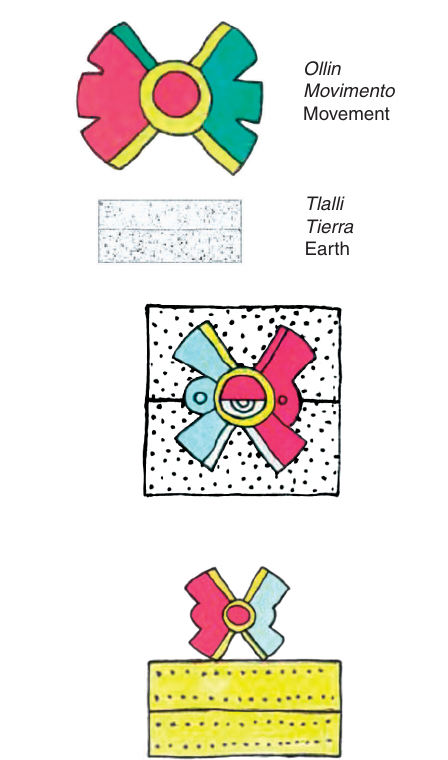
Fig. 2. Earth and Movement ( Tlalli and Ollin in Nahuatl Language) glyphs and their combination meaning Earthquake ( Tlalollin